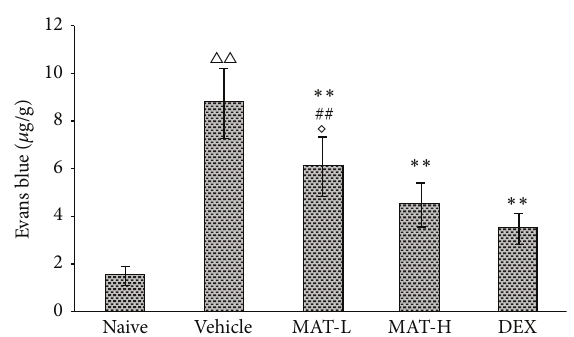
Figure 3: BBB integrity. Evans Blue was i.v. injected at day 17 p.i. and brains were harvested at 60min to determine Evans Blue extravasation. Results are expressed as mean ± SD ( 𝑛 = 8 each group). △△ 𝑃 < 0.01 , compared to naive group; ∗∗ 𝑃 < 0.01 , compared to vehicle group; ## 𝑃 < 0.01 , compared to DEX group; ◊ 𝑃 < 0.05 , comparison between MAT-L and MAT-H